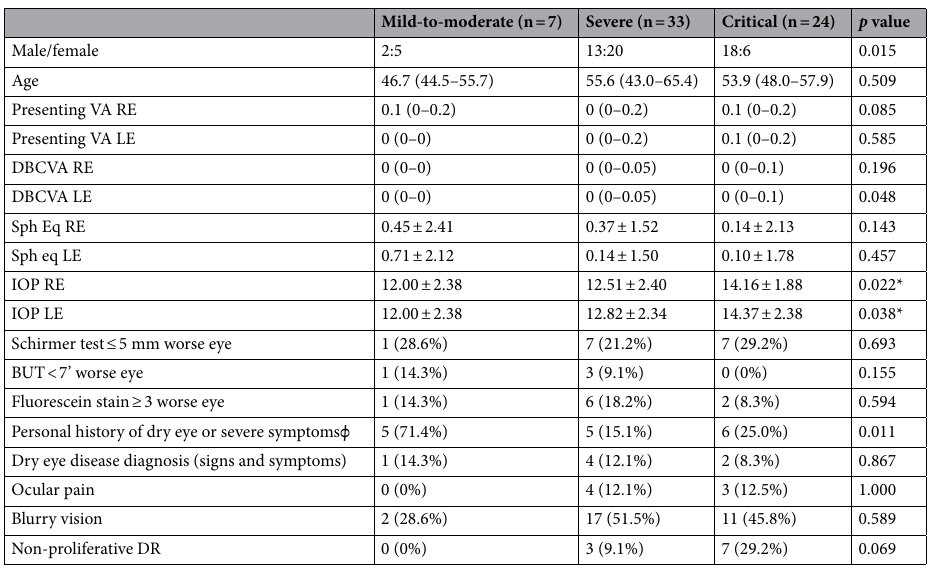
Table 1. Ocular and demographic data of patients recovered from COVID-19, according to the systemic classification of the disease severity (mild-to-moderate, severe, and critical). Data shown in mean ± SD, median (Interquartile ranges) or frequency (%). VA: visual acuity; RE: right eye; LE: left eye; DBCVA: distant best-corrected visual acuity; Sph Eq: Spheric equivalent; IOP: intraocular pressure; BUT: break-up time; DR: Diabetic retinopathy; Dryness or irritation; * (One-way ANOVA, between severe and ϕ